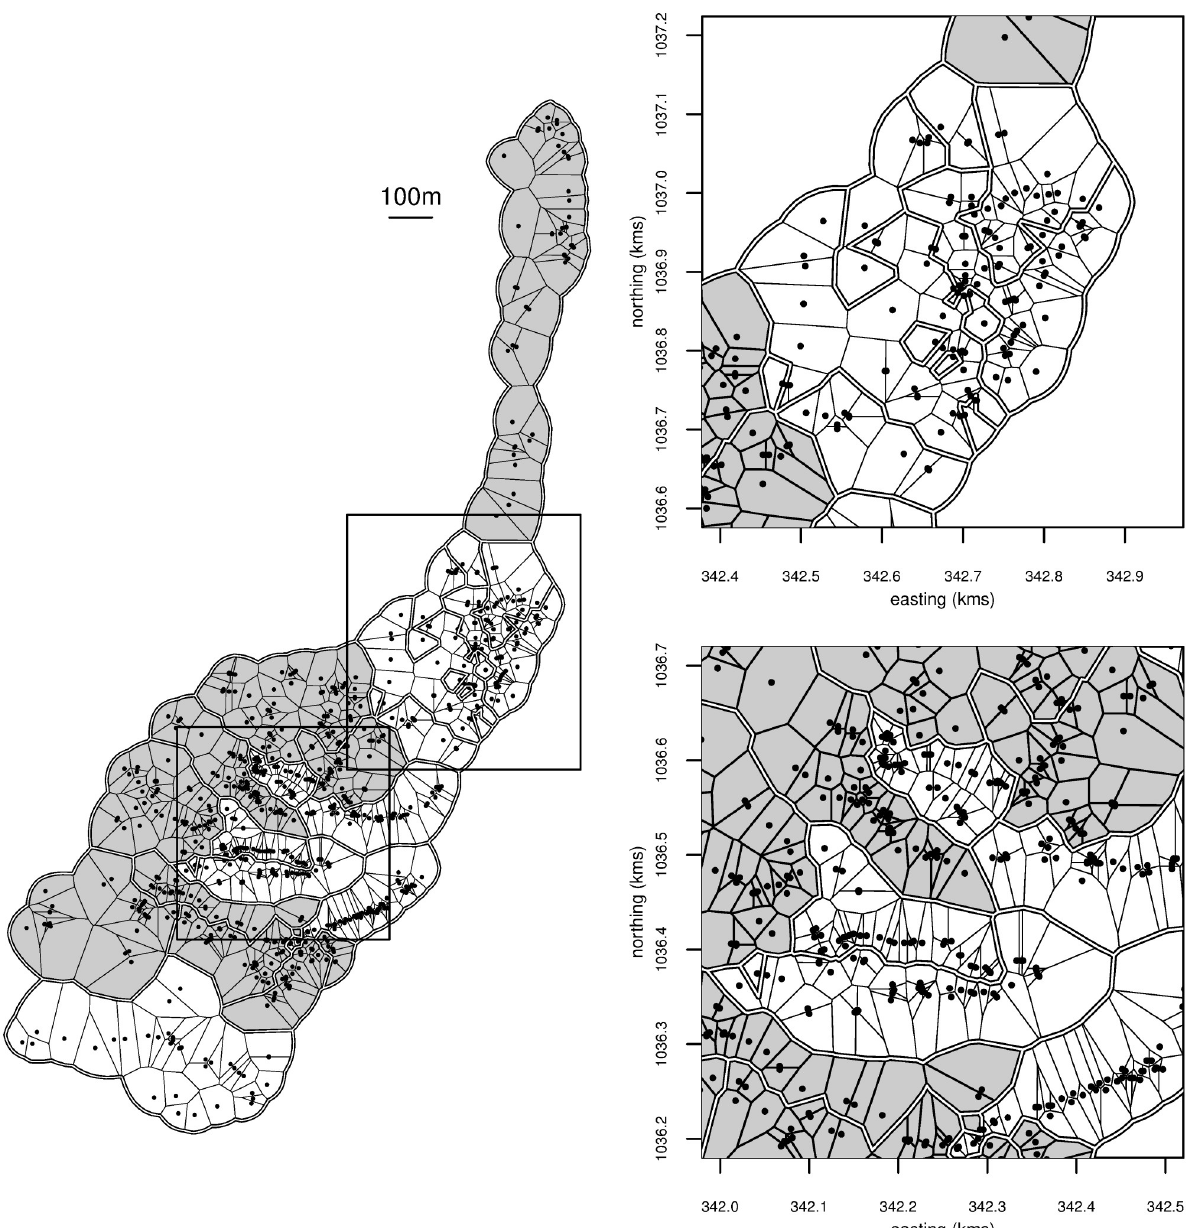
Fig 1. Spatial distribution of individuals in the Trujillo trial where each point represents a location, i.e. a house or, in the case of identical coordinates, a set of houses. There is one tile for each point, obtained using by Dirichlet tessellation. Dark tiles are intervention locations, white ones are control. Double lines are tile borders between clusters. The insets to the right are zoomed versions of the areas inside the rectangles.